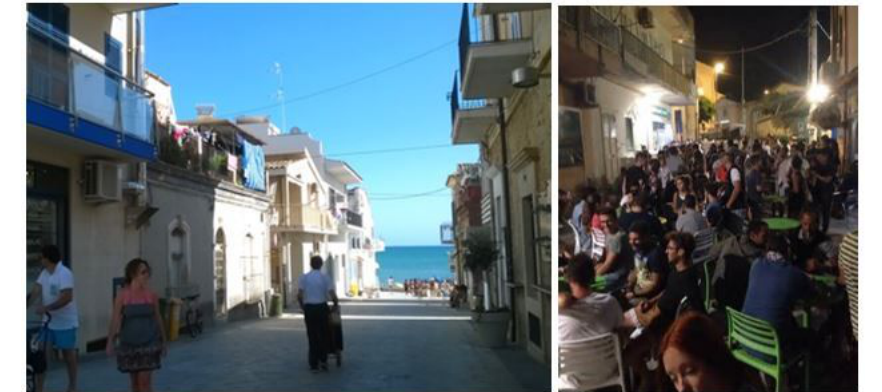
Figure 6: Tindari Street in daytime (on the left) and nighttime (on the right)